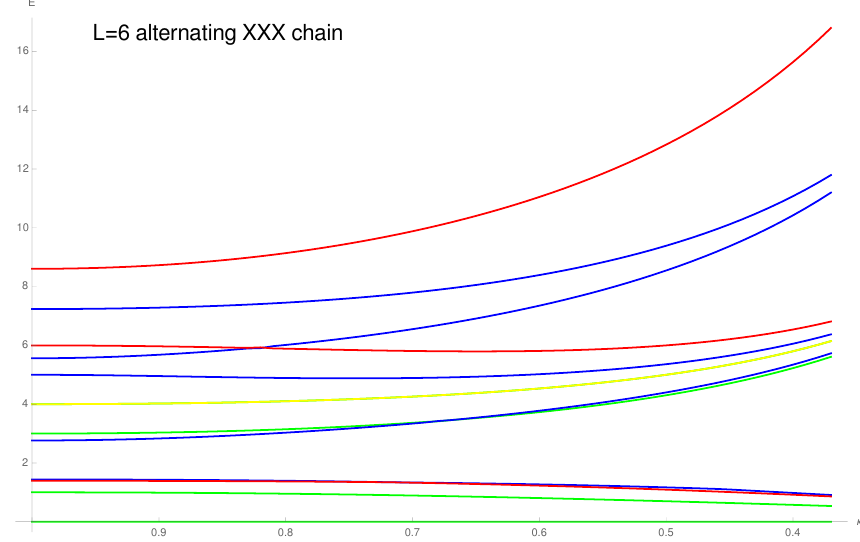
Figure 9 . The spectrum of the periodic (untwisted sector) L = 6 alternating chain as a function of κ . κ = 1 is the standard XXX Heisenberg model. Green denotes 1-magnon states, blue 2-magnon states and red 3-magnon states. The line starting at E = 4 is a degenerate 1-magnon and 3-magnon state. There is also a 1-magnon state at E=0. We have plotted down to κ = 0 . 4 for clarity. As κ decreases further, the eigenvalues bunch into groups with limiting values of 6 /κ, 4 /κ, 2 /κ and 0